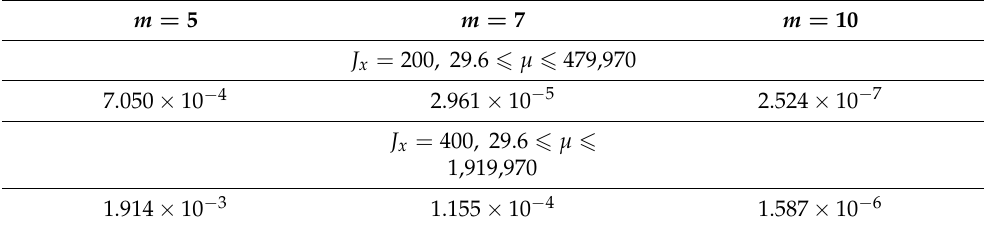
Table 6. Approximation errors (cid:107) ¯ E m (cid:107) for the discrete solution of the URA-BRASIL scheme (21) for different orders m of the rational approximation functions and J x = 200,400. m =